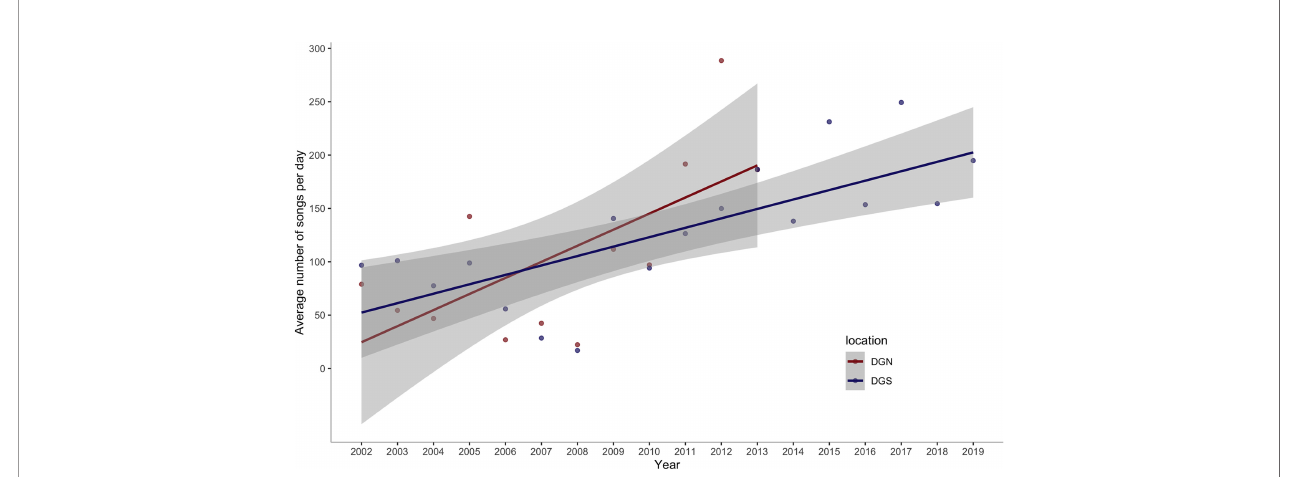
FIGURE 2 | Annual change in the average number of Chagos whale songs detected per day off Diego Garcia/Chagos Archipelago at the north-western (DGN) site where the linear trend has a slope of 15.1 songs/day/year (12.6%/year) with corresponding r = 0.56 and p-value of 0.06, and the south-eastern (DGS) site where the linear trend has a slope of 8.8 songs/day/year (7.7%/year) with corresponding r of 0.79 and p-value < 0.001. r is the Spearman rank coef fi cient of the average number of songs per day with